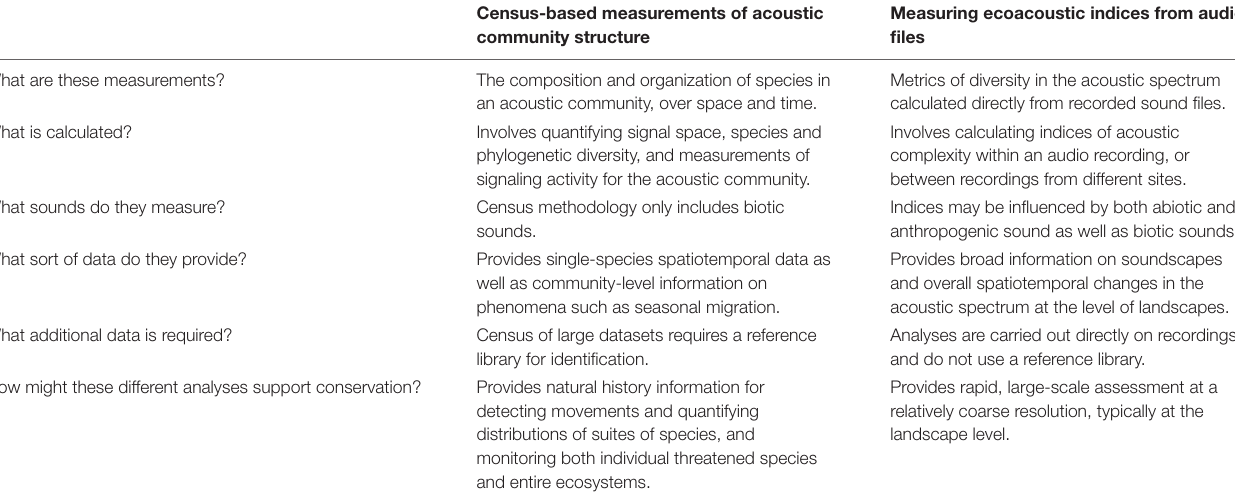
Census-based measurements of acoustic community structure